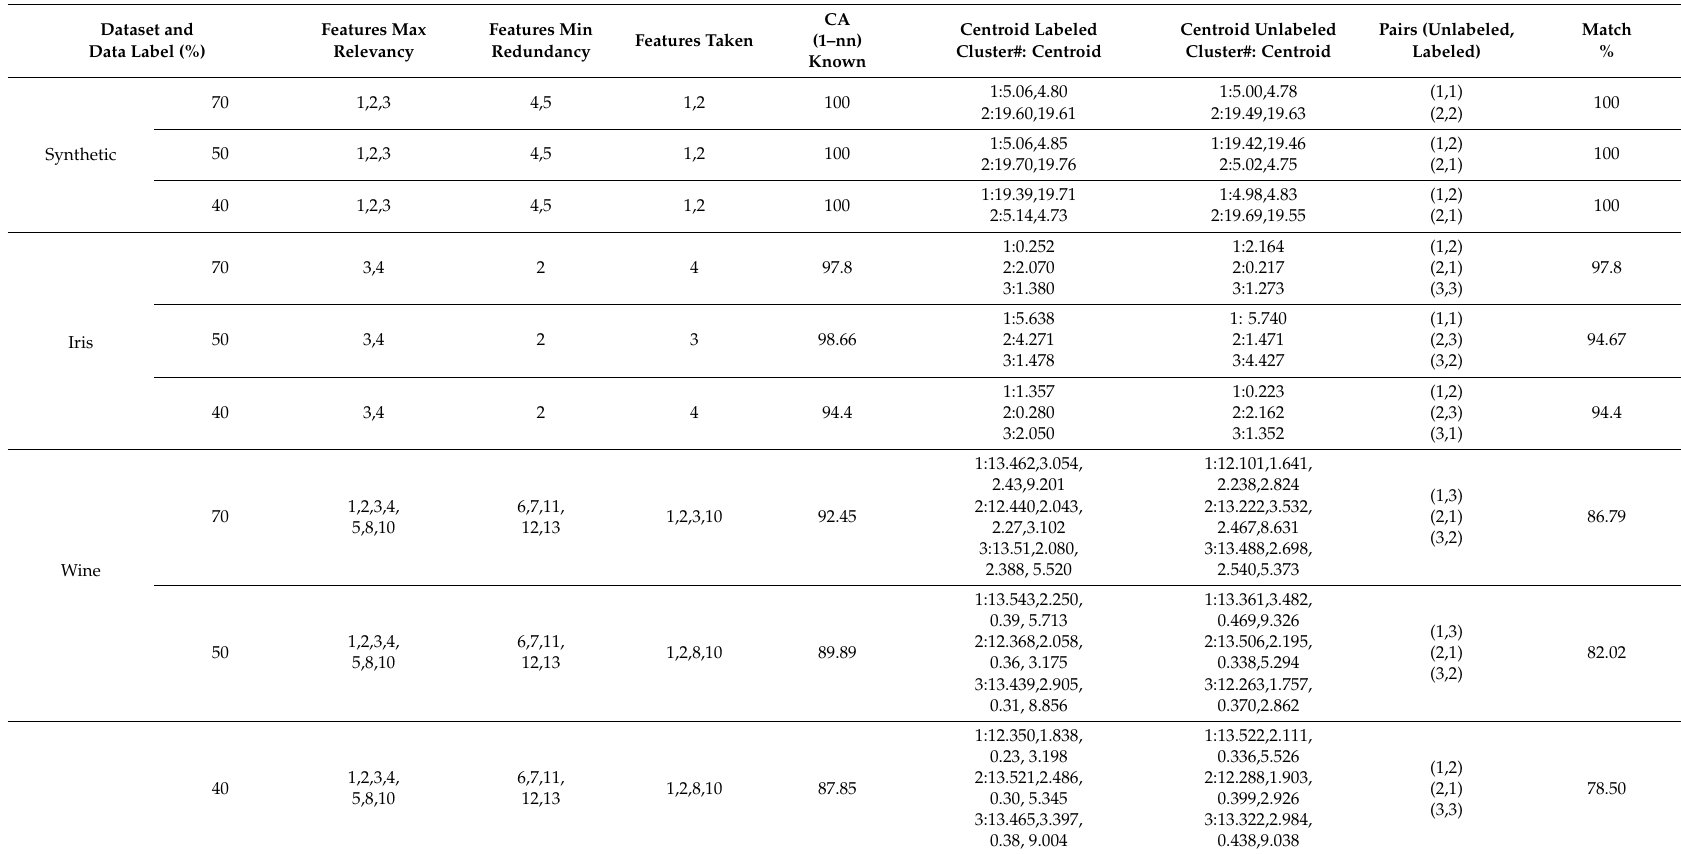
Table 6. Results of various parameters for